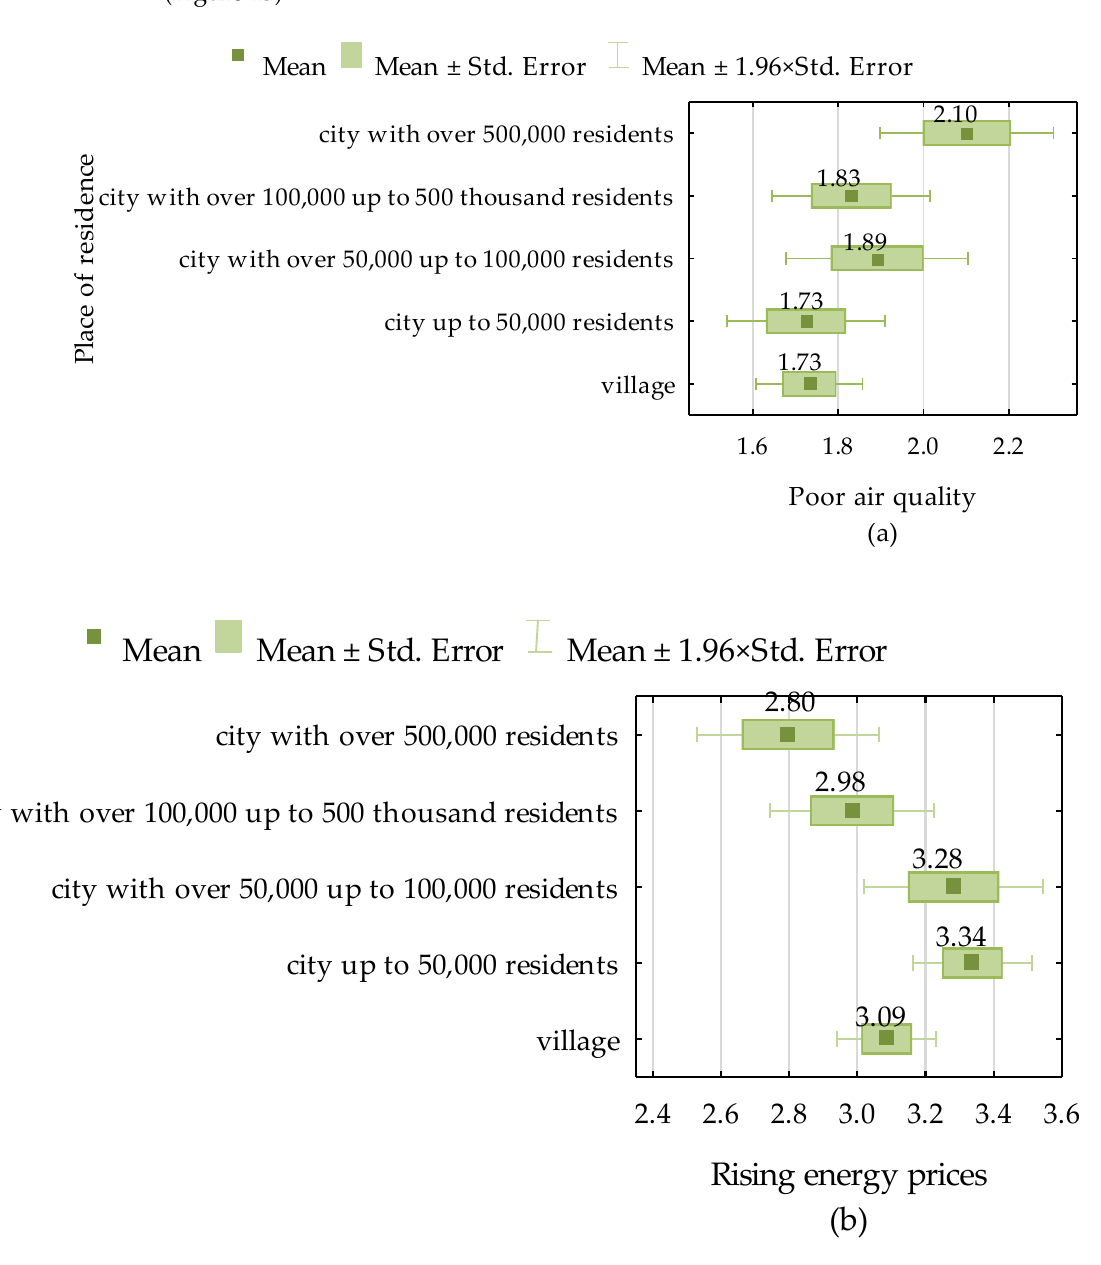
Figure 15. Assessment of factors encouraging investment in buildings using solely renewable energy sources (depending on the place of residence of a respondent): ( a ) poor air quality; ( b ) raising energy prices. Having conducted an energy audit and assessed the energy efficiency of a building was confirmed by 12.91% of the respondents. In turn, 48.06% of the respondents indicated that such activities had not taken place; 39.02% of respondents did not know (Figure 16).